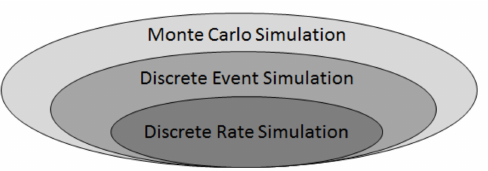
Figure 7. Relationship between Monte Carlo, discrete event, and discrete rate